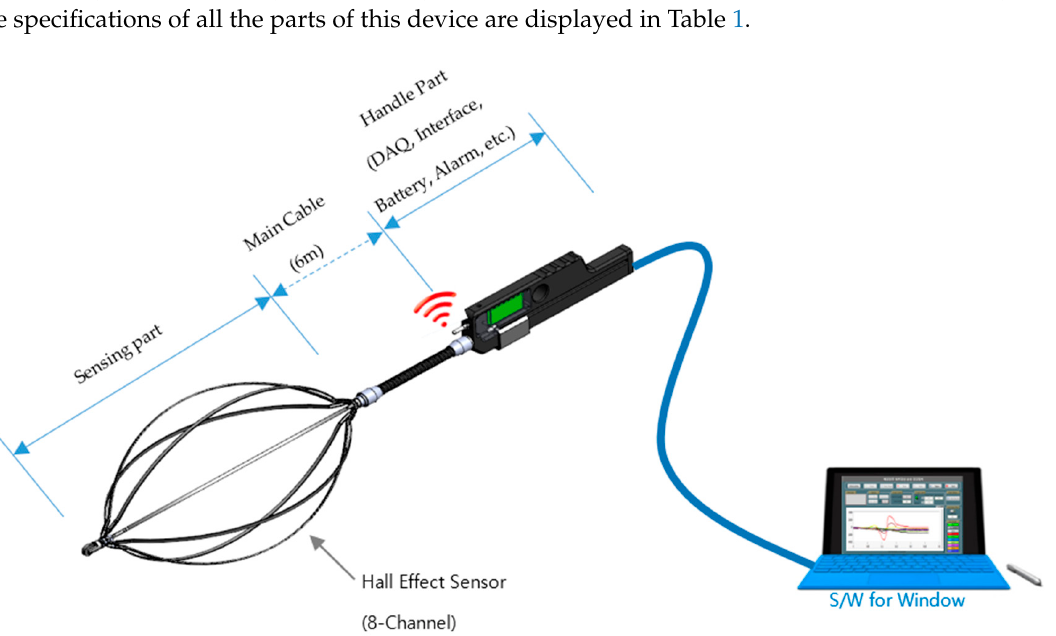
Figure 1. Magnetic sensing device with eight channels.